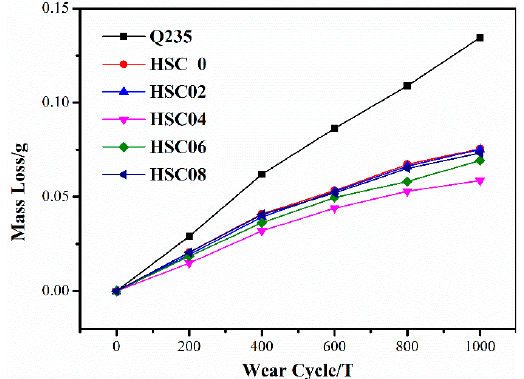
Figure 11. Weight loss–wear cycle curves.